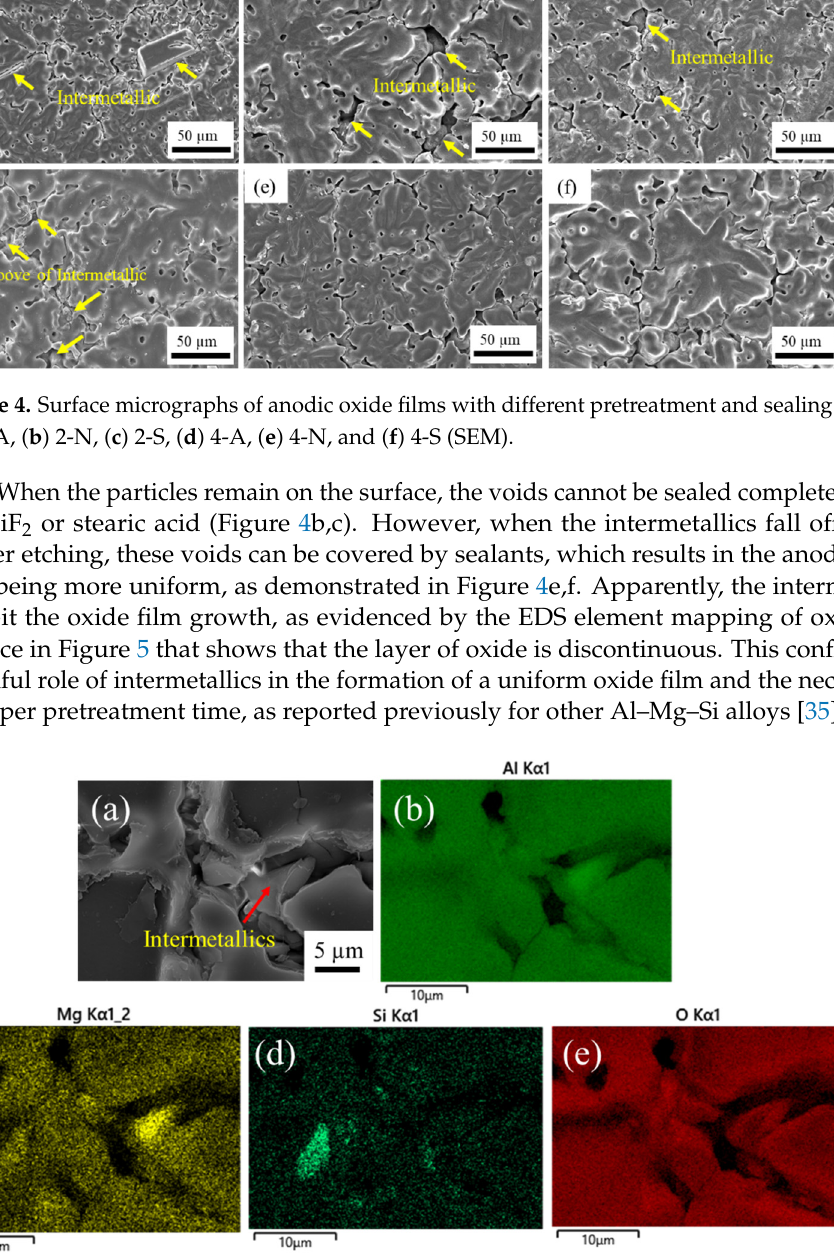
Figure 3. SEM micrographs of the A535 substrate surface ( a , c ) and cross-section surface ( b , d ) after alkaline etching for ( a , b ) 2 min and ( c , d ) 4 min.